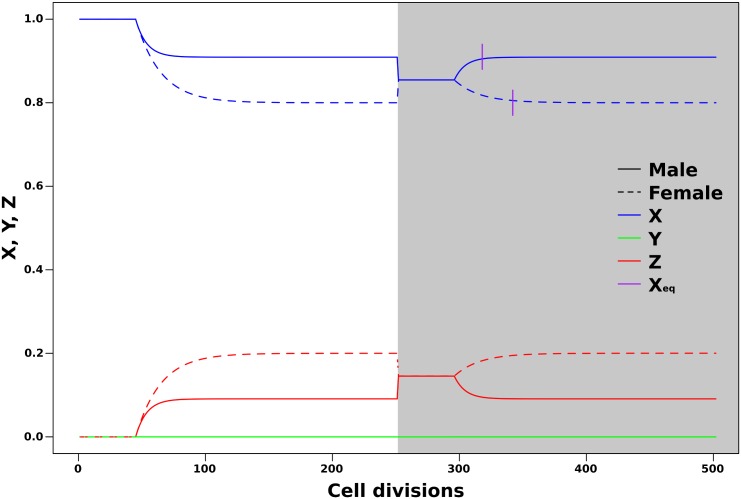
Methylation dynamics between sexes (dashed lines vs. solid lines) during development and across two generations (shades of grey) with 250 cell divisions each.Parameter values used in the simulations are specified in Table 1. Vertical bars mark cell divisions at which the equilibrium is achieved.